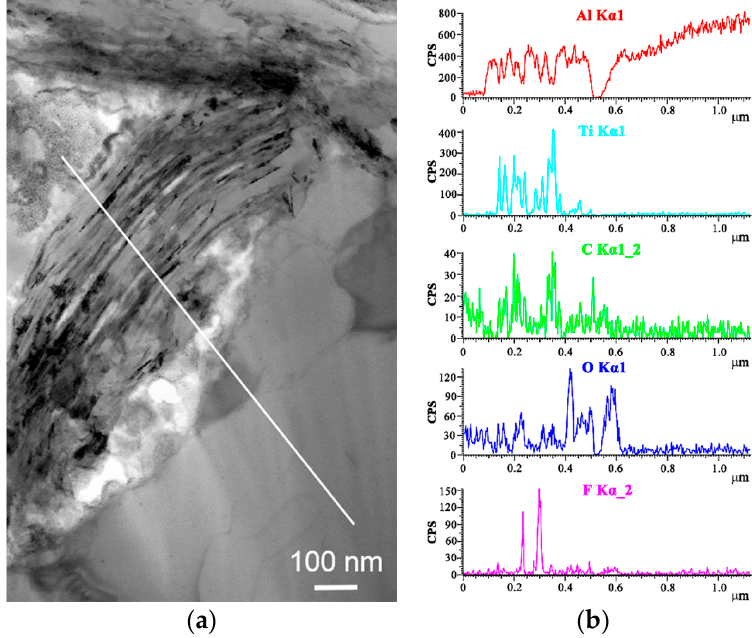
Figure 4. TEM image ( a ) and EDS results of the Ti 3 C 2 T x /Al sample sintered at 650 °C ( b ). The EDS scan analysis along the line in ( a ) showing the elemental distribution of Al, Ti, C, O, and F.